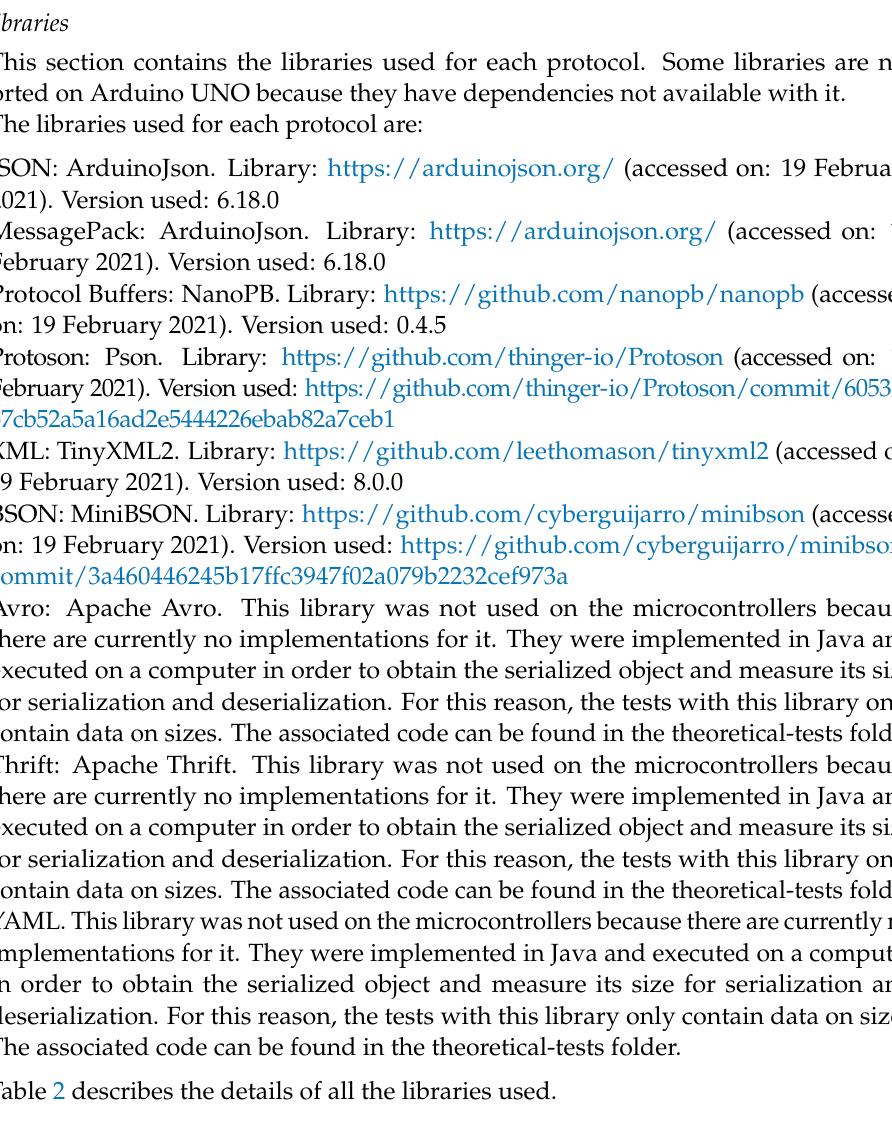
Table 2. Libraries used for comparison of data serialization